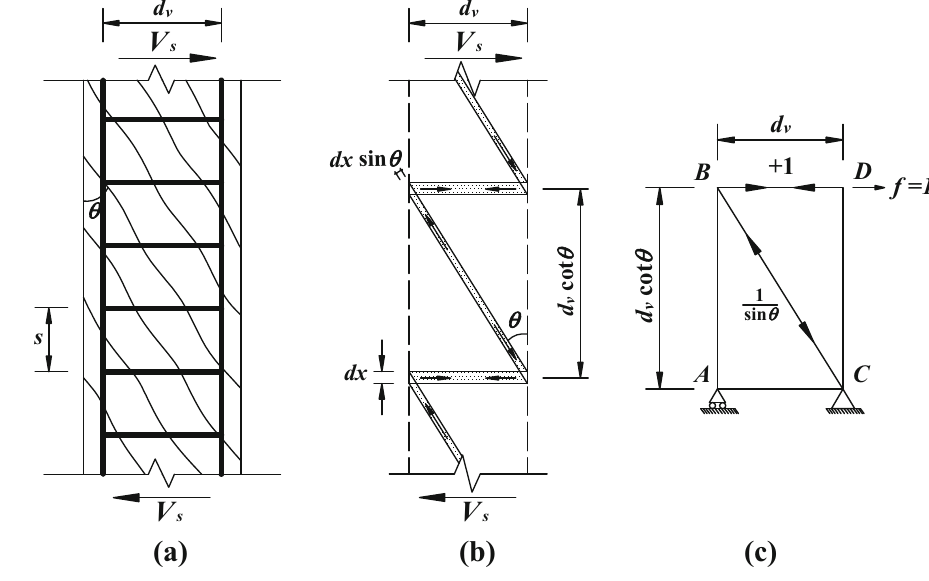
Fig. 2 Diagram of CATM.